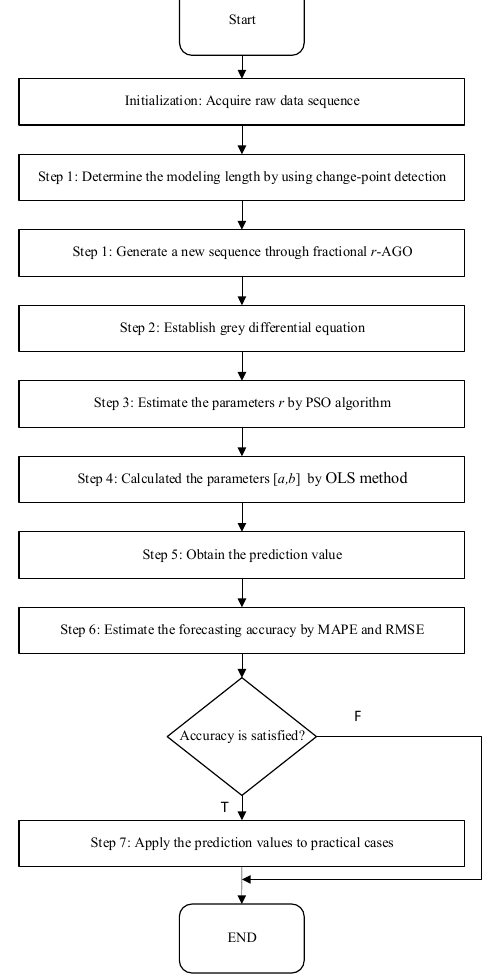
Figure 1. The process of the CPD-FGM(1,1) model.